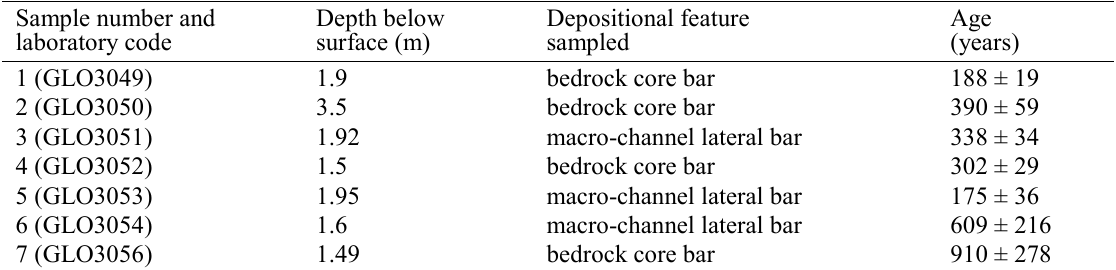
Table 2 Optically stimulated luminescence ages from basal sediments on the Sabie River, South Africa*). Sample number and laboratory code